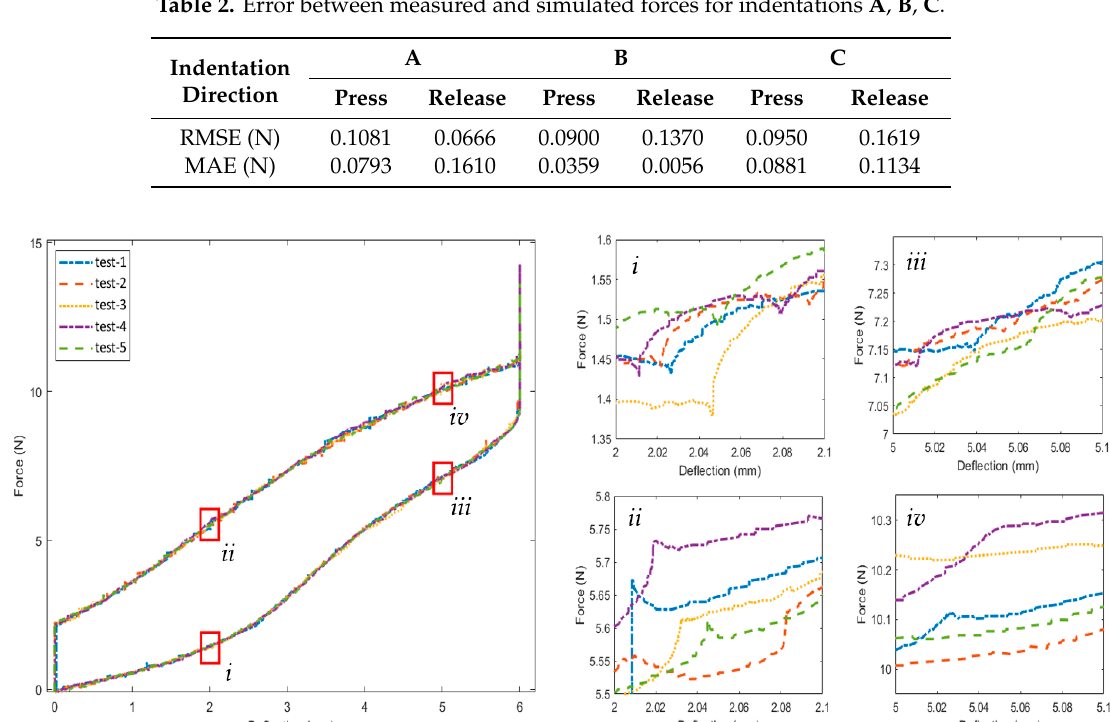
Figure 10. Force versus deflection plots of five experiments where the user performs indentation A. i, ii, iii and iv are zoomed-in regions.